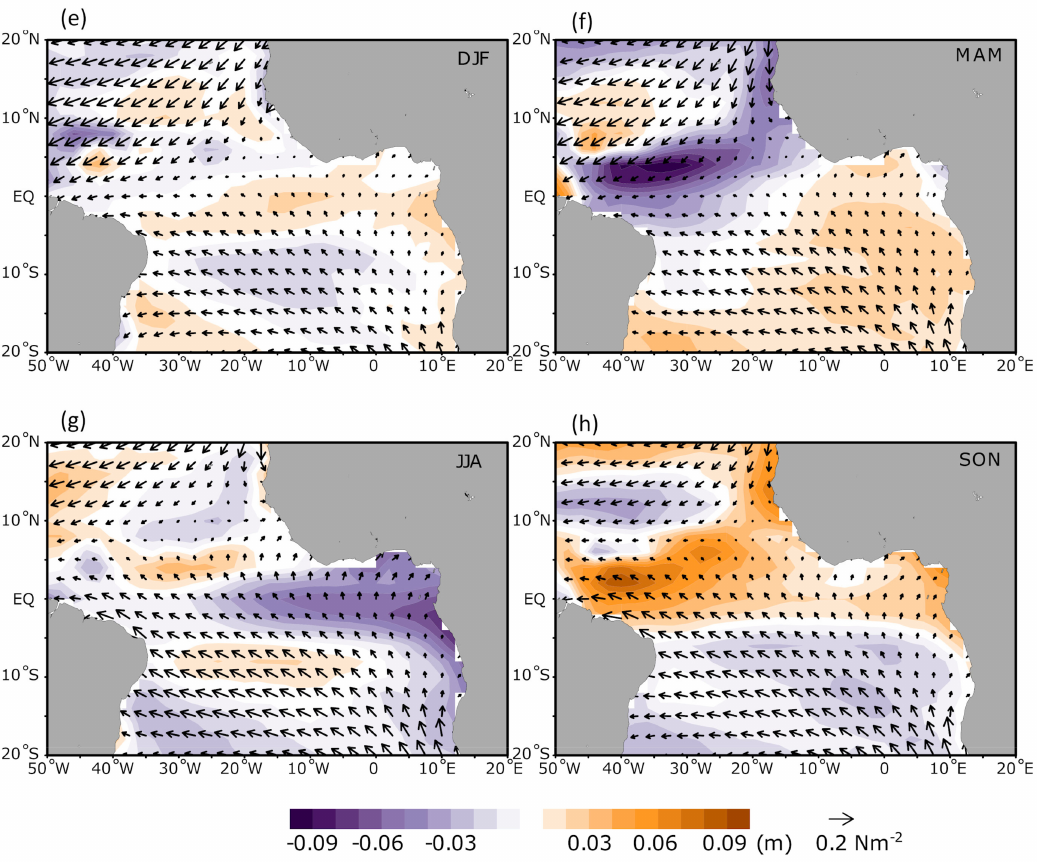
Figure 2. ( a – d ) Climatology of seasonal sea surface temperature obtained from TropFlux (1979–2011) (https: // incois.gov.in / tropflux / index.jsp; accessed on 12 June 2019). ( e – h ) Climatology of surface wind stress obtained from ERA-Interim (1979–2011) and seasonal anomaly of sea surface height from annual-mean obtained from AVISO (1993–2000). December-January-February (DJF); March-April-May (MAM); June-July-August (JJA); September-October-November